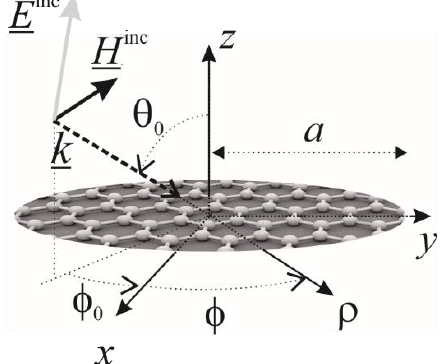
Figure 1. Geometry of the problem.